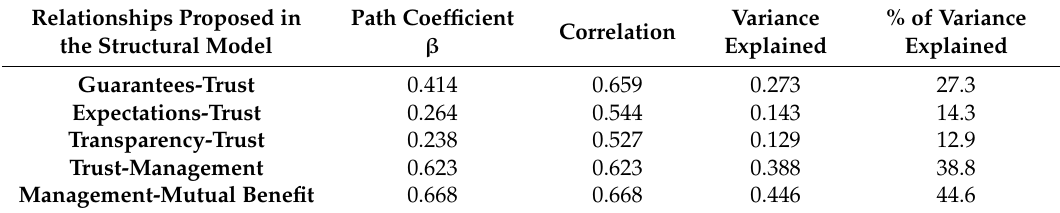
Table 4. Contribution of the predictive variable to the variance